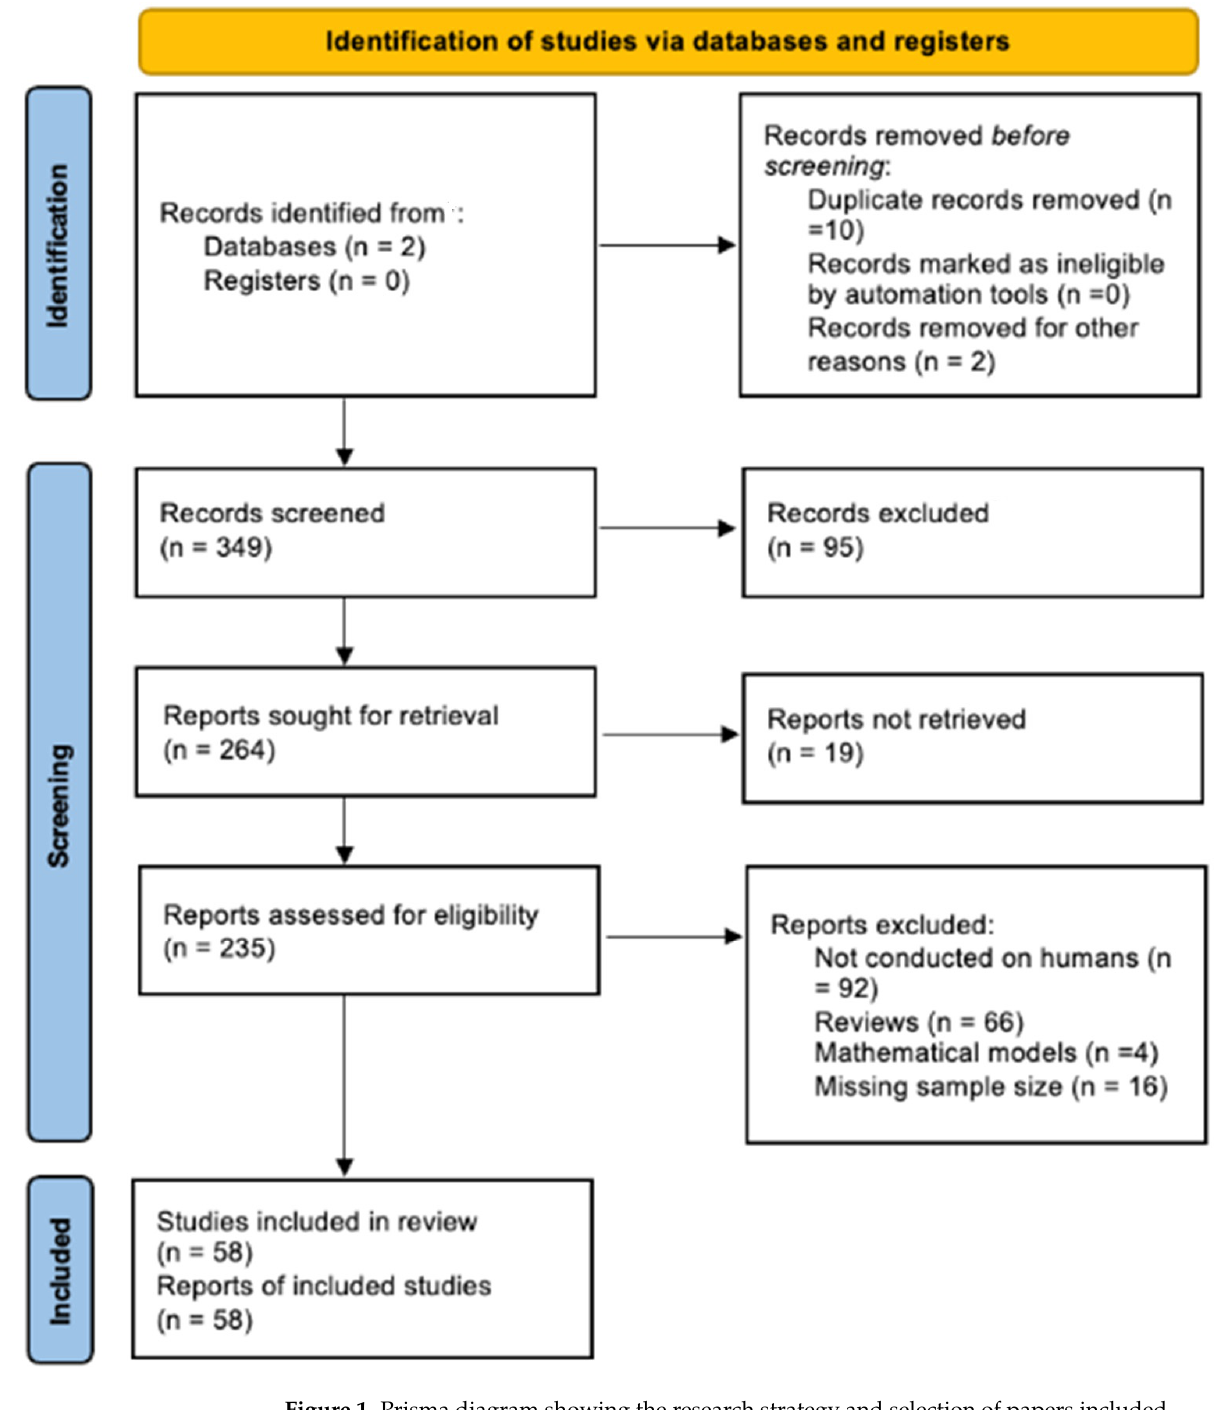
Figure 1. Prisma diagram showing the research strategy and selection of papers included.